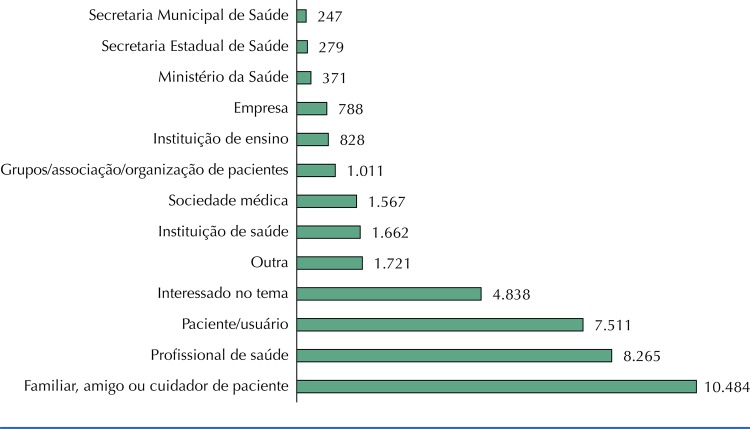
Tipo de público participante das consultas públicas realizadas pela Comissão Nacional de Incorporação de Tecnologias em Saúde no SUS (conforme autodeclarado nos formulários das consultas públicas), no período de 2012 a 2017. Fonte: Conitec, 2018.